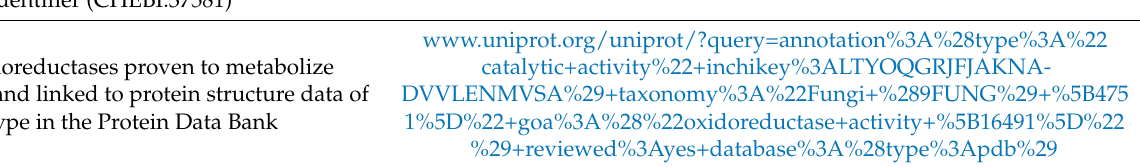
patulin, by structure (using the first two blocks of the InChIKey)